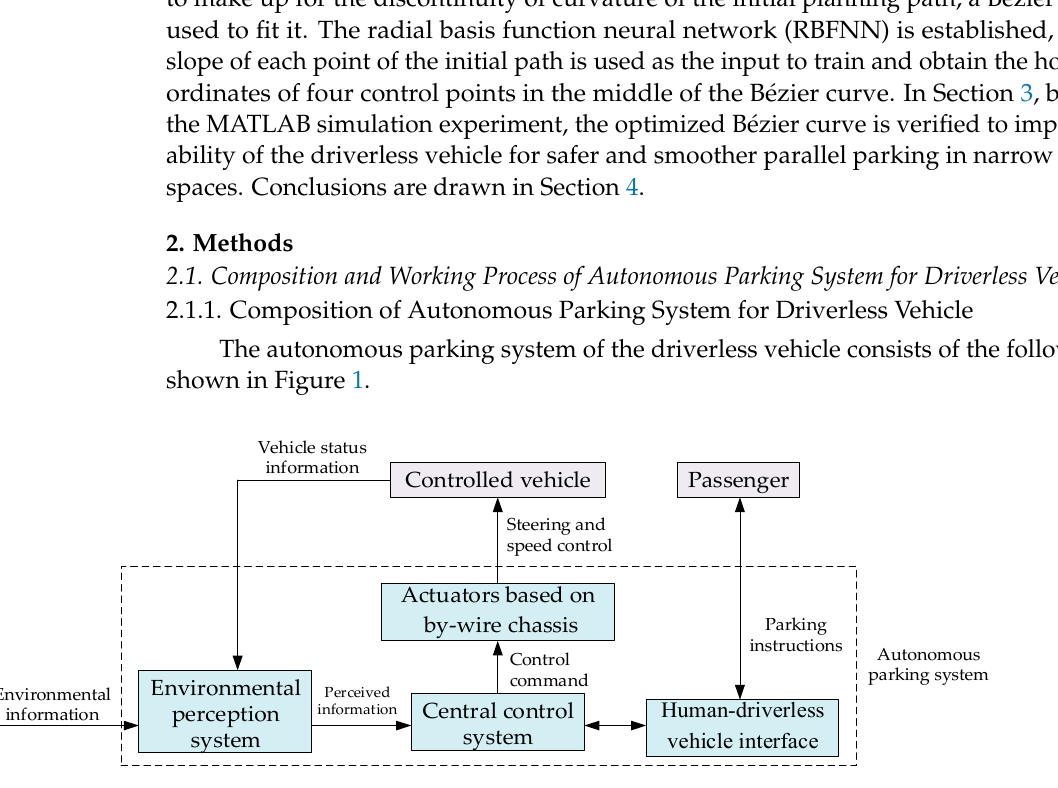
Figure 1. Composition of autonomous parking system.